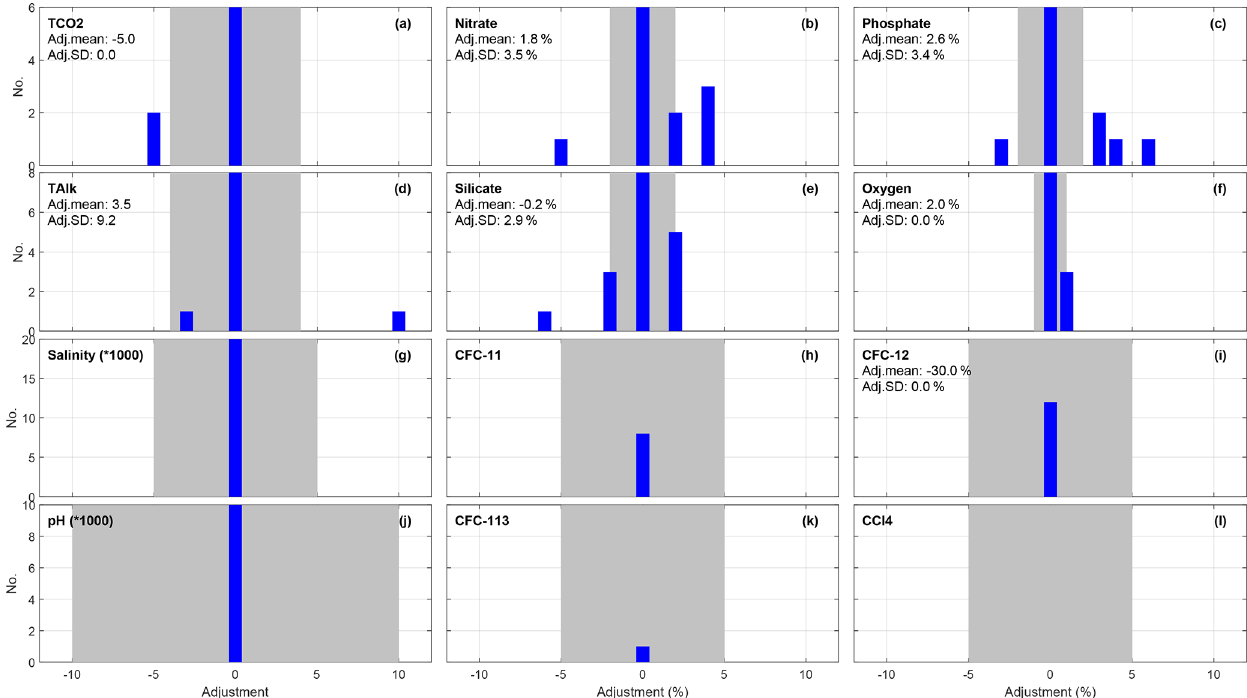
Figure 6. Distribution of applied adjustments for each core variable that received secondary QC in micromoles per kilogram (µmolkg − 1 ) for TCO 2 and TAlk and unitless for salinity and pH (but multiplied by 1000 in both cases so a common x axis can be used), while for the other properties adjustments are given in percent ((adjustment ratio − 1) × 100). Gray areas depict the initial minimum adjustment limits. The figure includes numbers for data subjected to secondary quality control only. Note also that the y -axis scale is set to render the number of adjustments visible, so the bar showing zero offset (the 0bar) for each variable is cut off (see Table 6 for these numbers). Table 7. Improvements resulting from quality control of the 43 new cruises per basin and for the global dataset. The values in the table are the weighted mean of the absolute offset of unadjusted and adjusted data versus GLODAPv2.2020. The total number of valid crossovers in the global ocean for the variable in question is n . The values in this table represent the inter-cruise consistency in the GLODAPv2.2021 product. ARCTIC